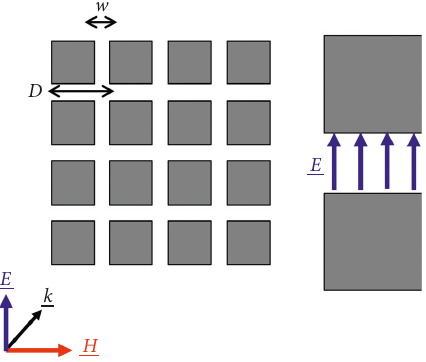
Figure 6: Array front view with single bow-tie elements, FSS, and mast. The array’s main dimensions are shown.